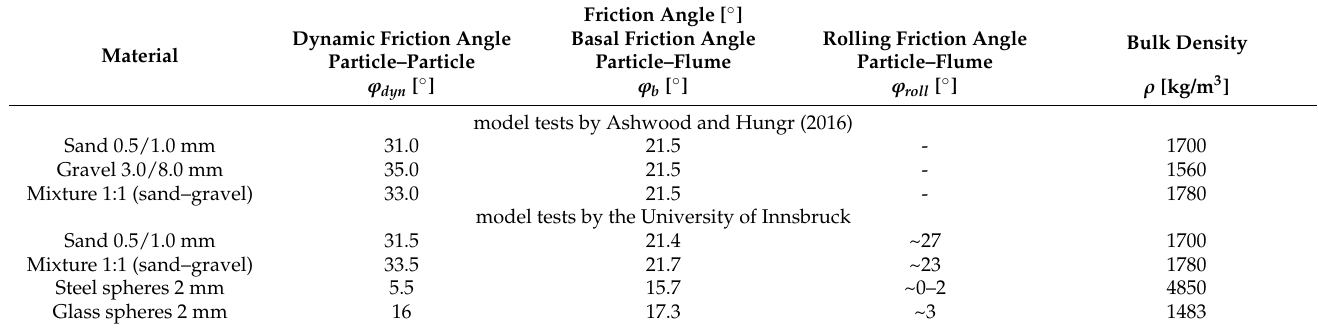
Table 3. Material parameters according to [1] and the University of